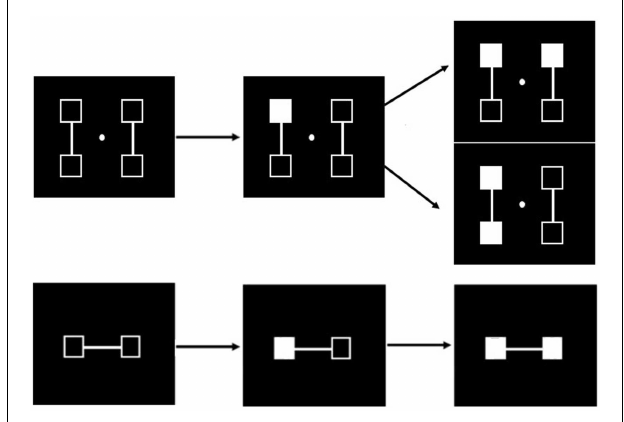
FIGURE 5 | Illustration of the successive events in the simultaneity/asynchrony discrimination task in case of an asynchrony (from left to right) .When four locations are used (upper row) and the first square is filled in (middle figure in the upper row), there are two possible locations for the second one (figure on the right), and there is thus an uncertainty regarding the location of the second stimulus.The spatial location of the second stimulus is always predictable when only two locations are used (lower row).These two experiments have been conducted in two different groups of participants (Lalanne et al.,